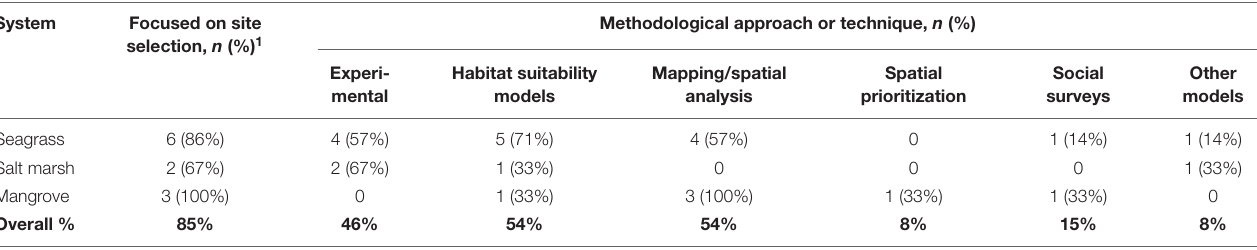
TABLE 3 | Number (and percent) of papers meeting our spatial planning criteria that were focused specifically on site selection (those that did not focused on spatial scale), and methodological approaches used in each study. System